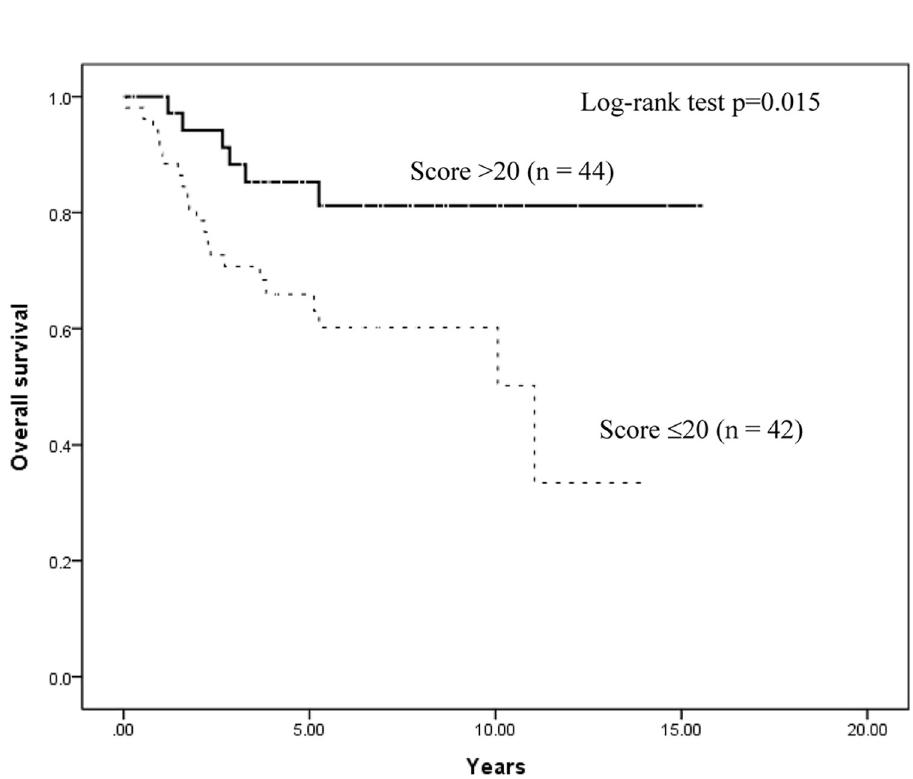
Fig 4. Kaplan–Meier analysis stratified according to TET1 expression score. Analysis to assess the prognostic value of the TET1 immunoreactivity in relation to OS.